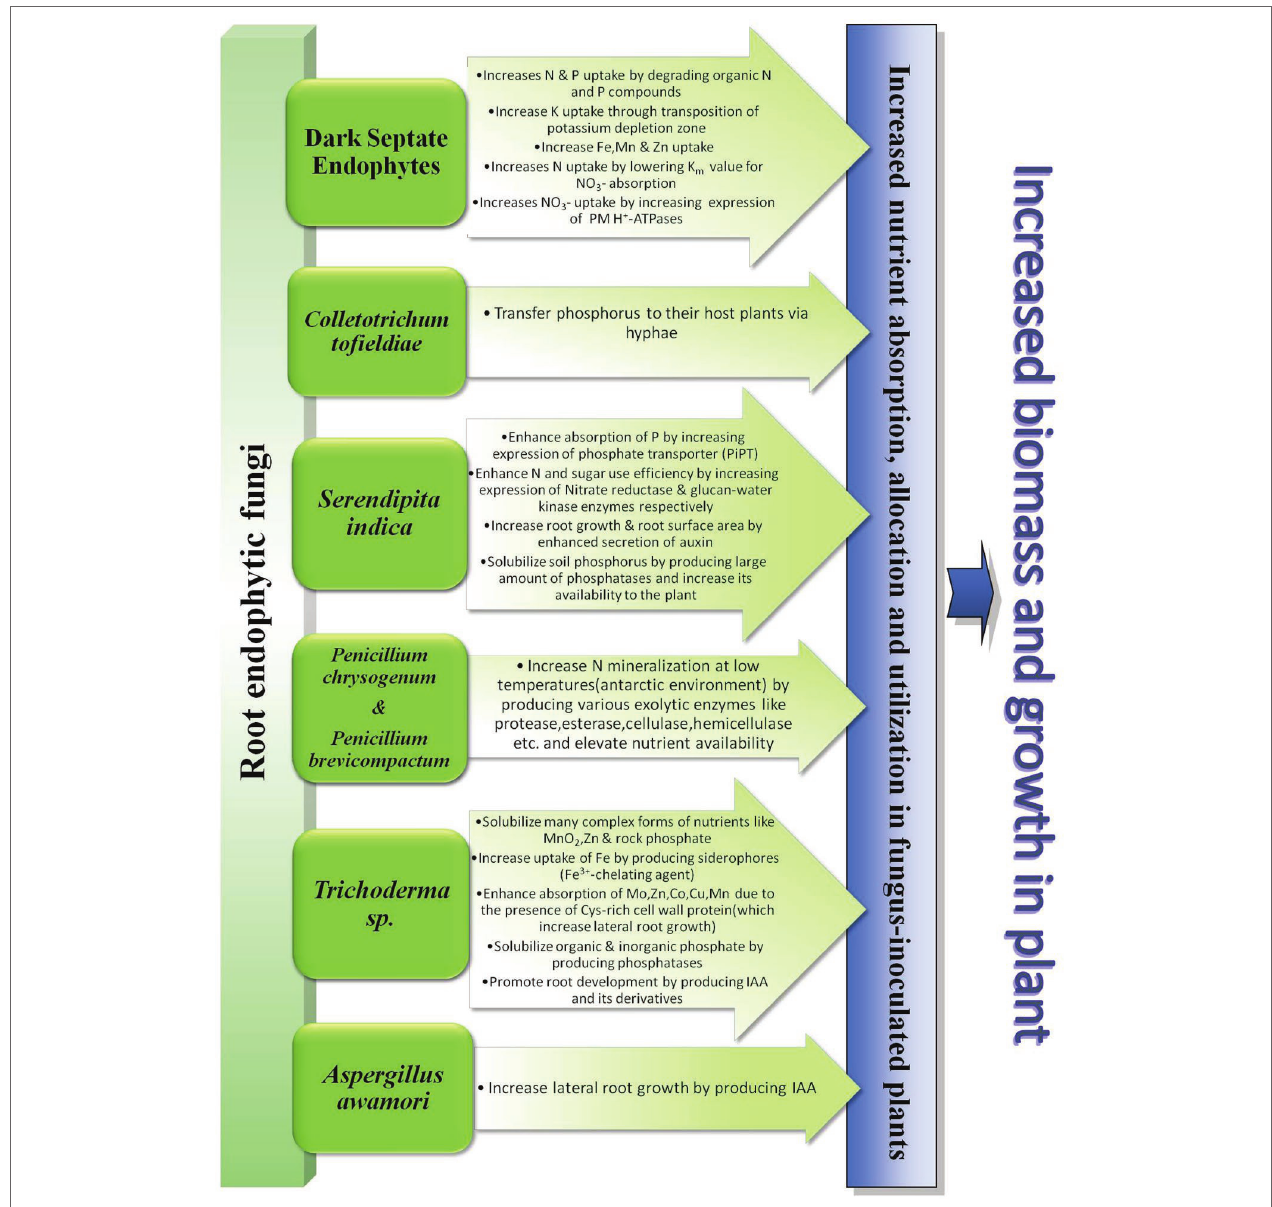
FIGURE 1 | Diagrammatic presentation of the role of root endophytic fungi in plant nutrient